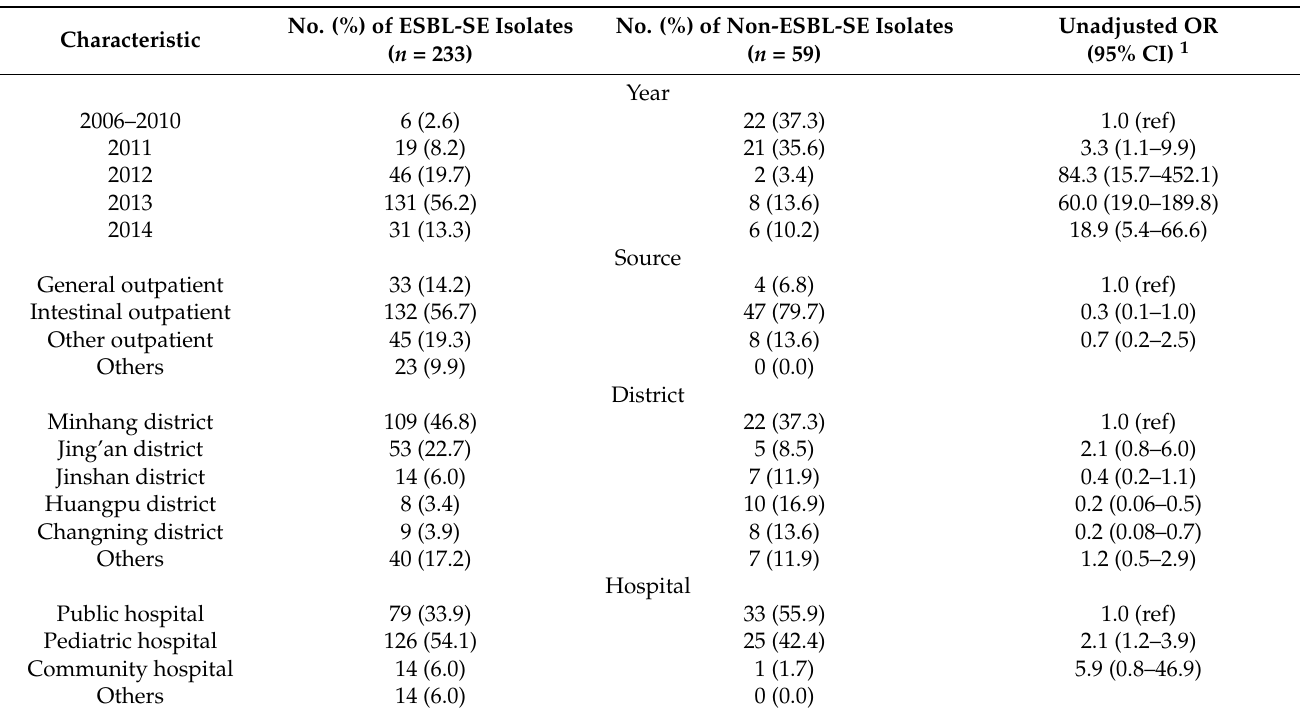
Table 1. Clinical background information of ESBL-producing S . Enteritidis (ESBL-SE) and non-ESBL-producing S . Enteritidis (non-ESBL-SE) isolates 1 .